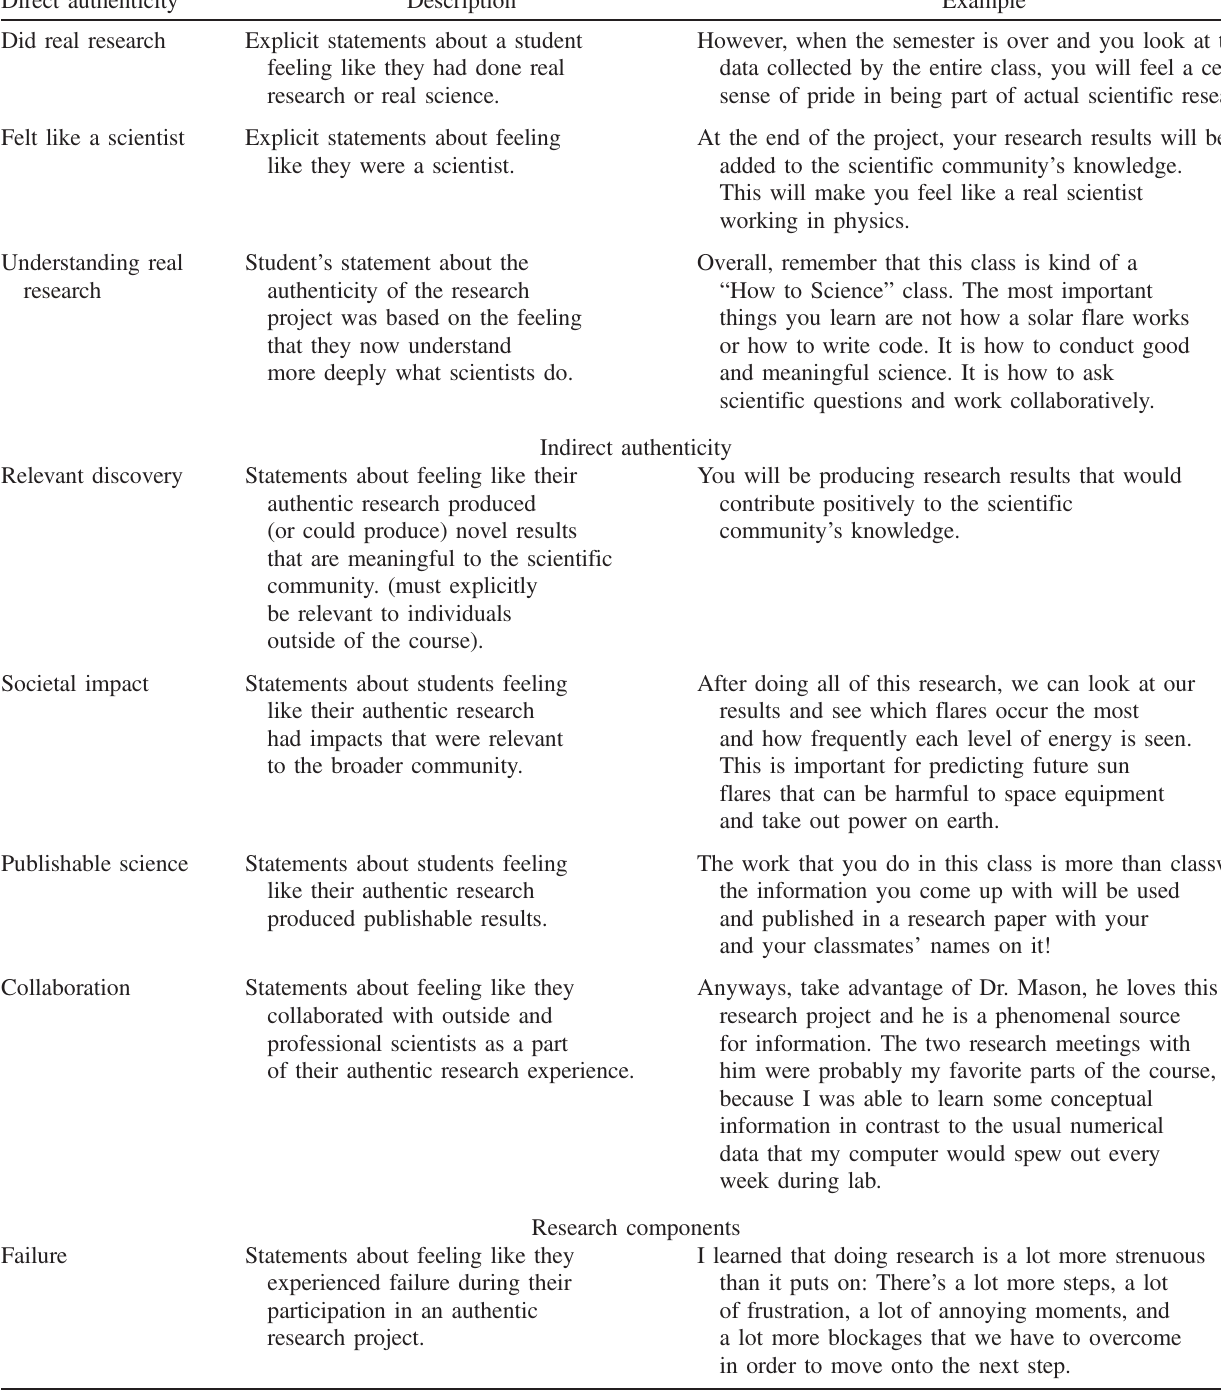
Table IV is a table consisting of the full codebook used in this work. The codebook was first developed and then grouped into three larger codes (direct authenticity, indirect authenticity, and research components) and the original codes became subcodes of these overarching codes. TABLE IV. Codebook used to analyze student responses to the memo to future researchers